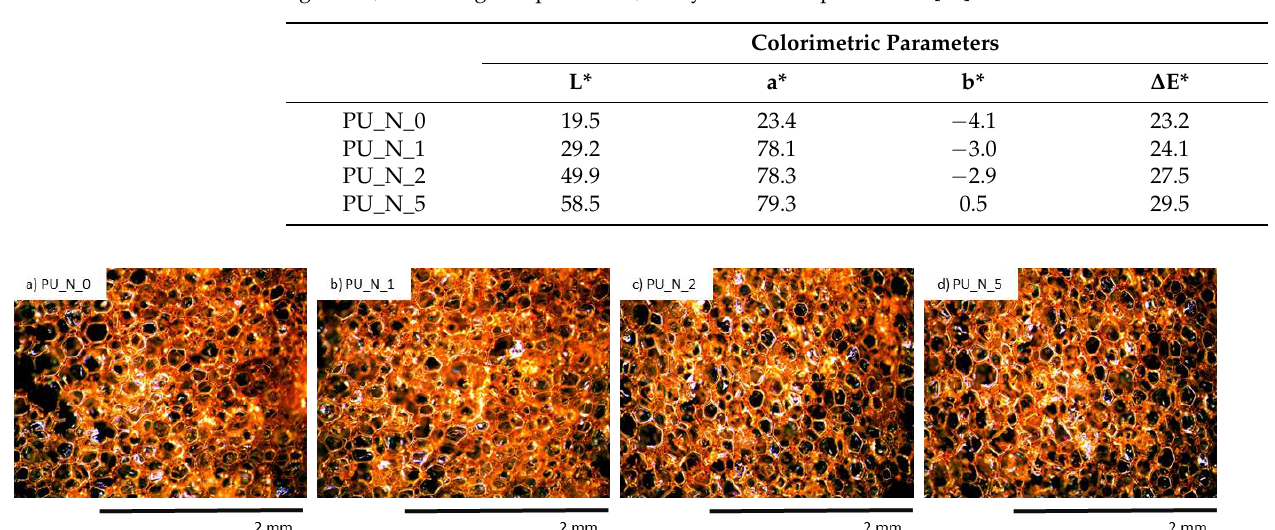
Table 7. Col or analysis of PU foams after UV aging, where ΔE*— total color change, L* — degree of Table 7. Color analysis of PU foams after UV aging, where ∆ E*—total color change, L*—degree of lightness, a* — red/green parameter, b* — yellow/blue parameter. [10]. lightness, a*—red/green parameter, b*—yellow/blue parameter. [10].